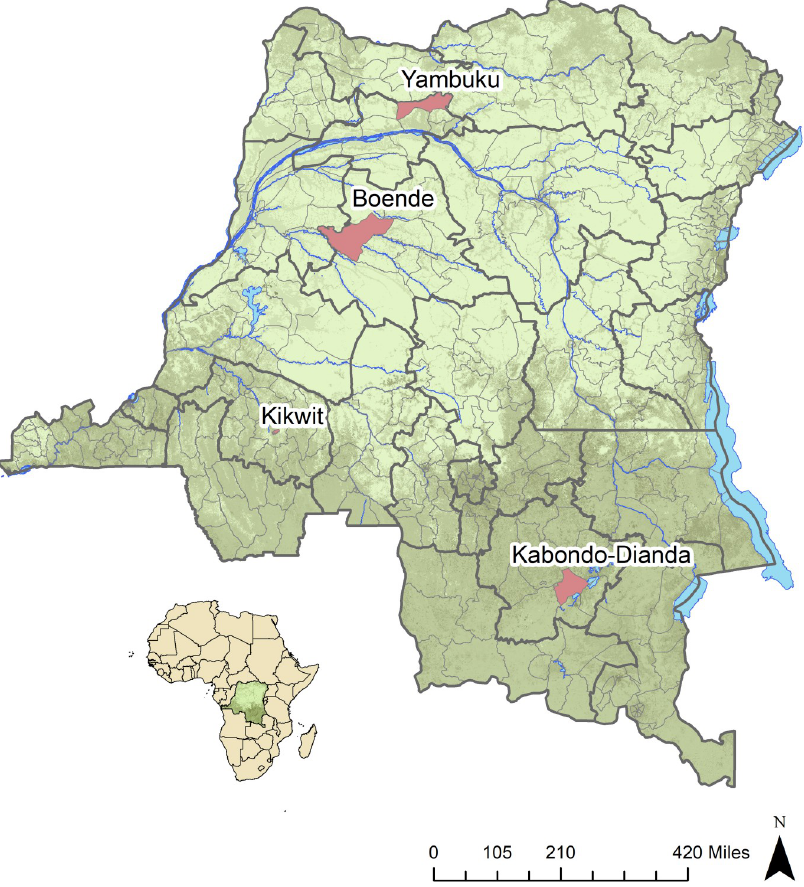
Fig 1. Map of the Democratic Republic of the Congo with health zones of study sites highlighted in red. Base layer from https://www.arcgis.com/home/item.html?id=10df2279f9684e4a9f6a7f08febac2a9